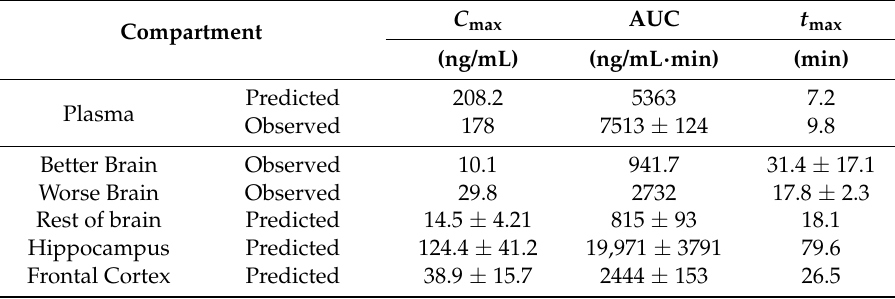
Table 5. Summary of predicted and observed pharmacokinetic parameters of morphine in plasma and regional brain compartments in